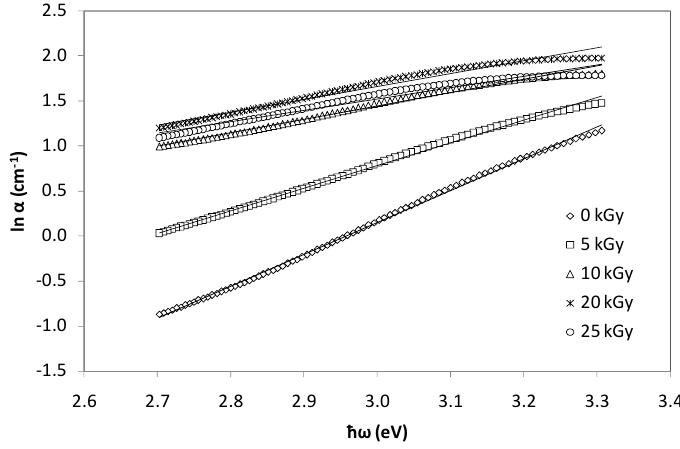
Figure 8. Optical absorption coefficient of (TeO y = x = 0.5% mol; 0.7% mol at various irradiation exposure. The line represents the pattern.